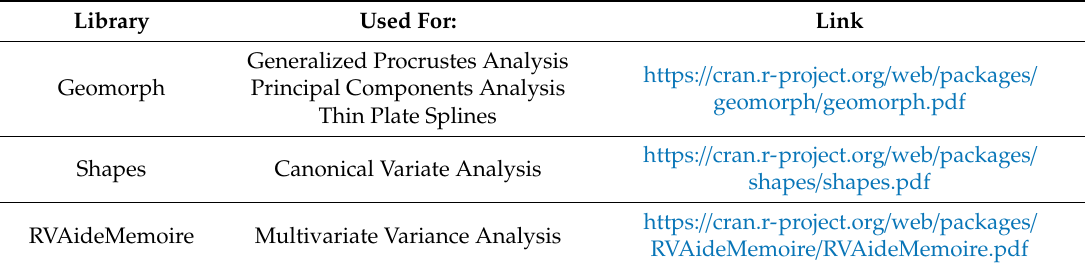
Table A1. Table presenting the R libraries used for geometric morphometric applications.